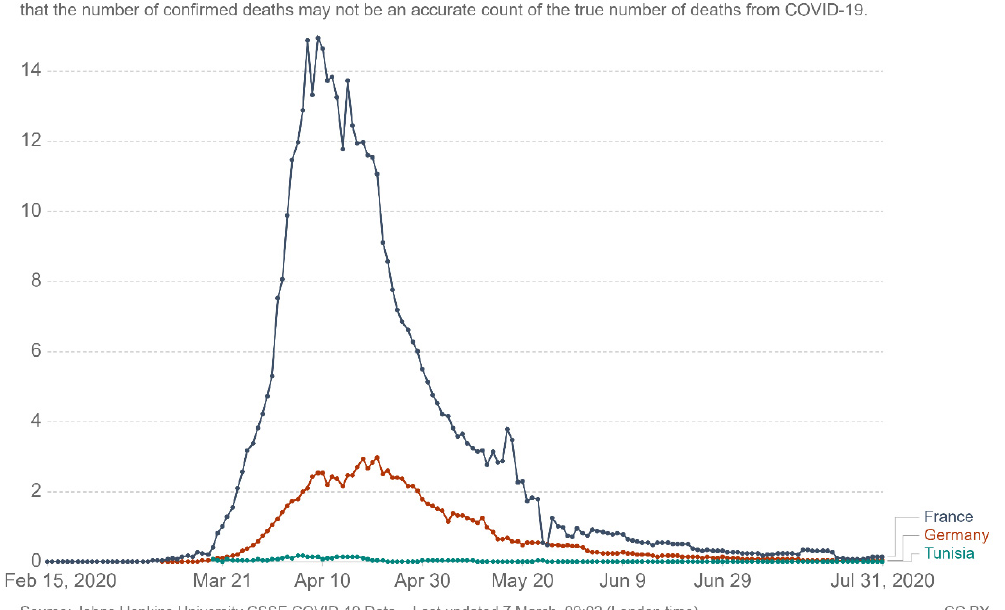
Figure 1. Shown is the rolling 7-day average of coronavirus cases in France, Germany, and Tunisia from 1 February 2020 to 31 July 2020. Source: Max Roser HR, Esteban Ortiz-Ospina, Joe Hasell. Posted online on OurWorldInData.org, 30 Jan- uary 2021.